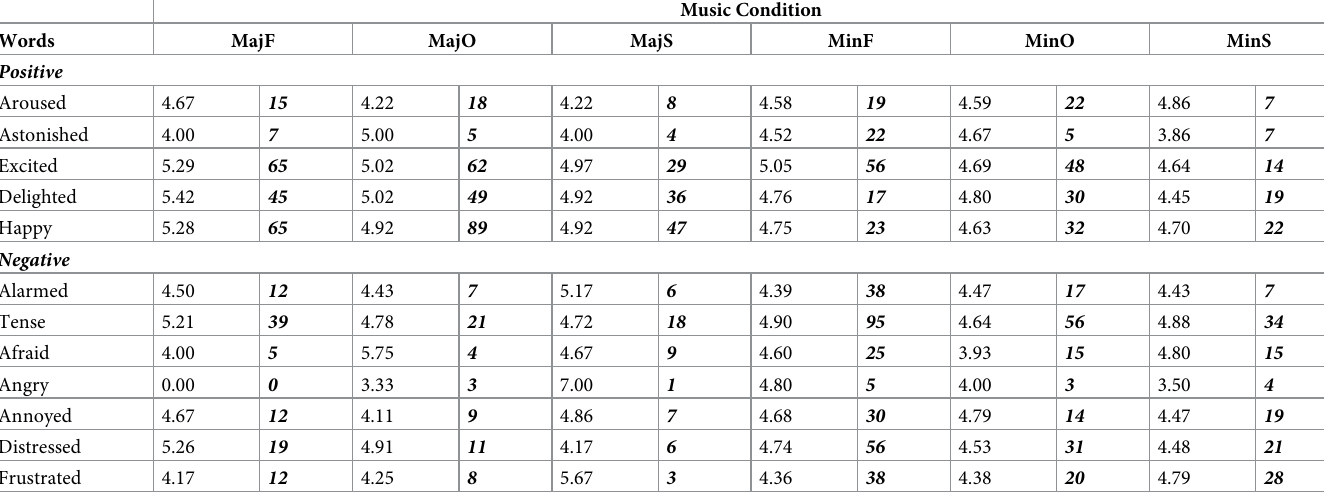
Music Condition